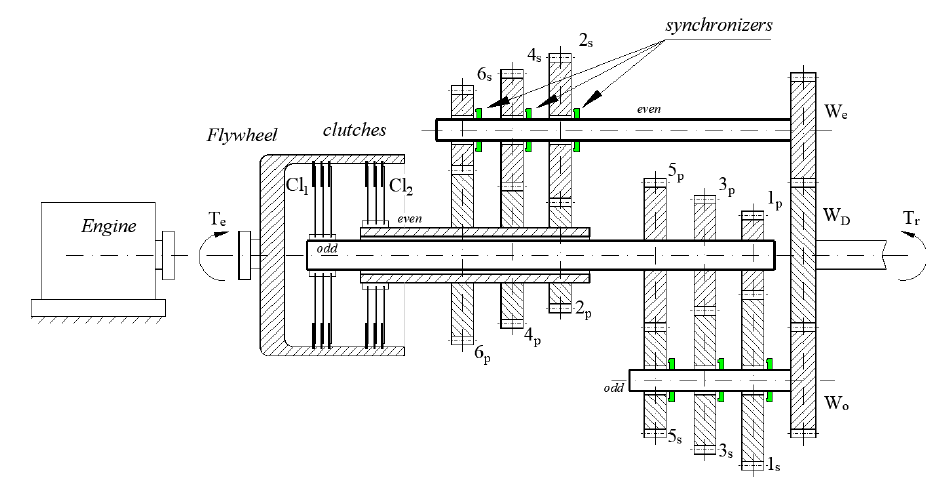
Figure 1. Schematic of a Dual Clutch Transmission system for automotive